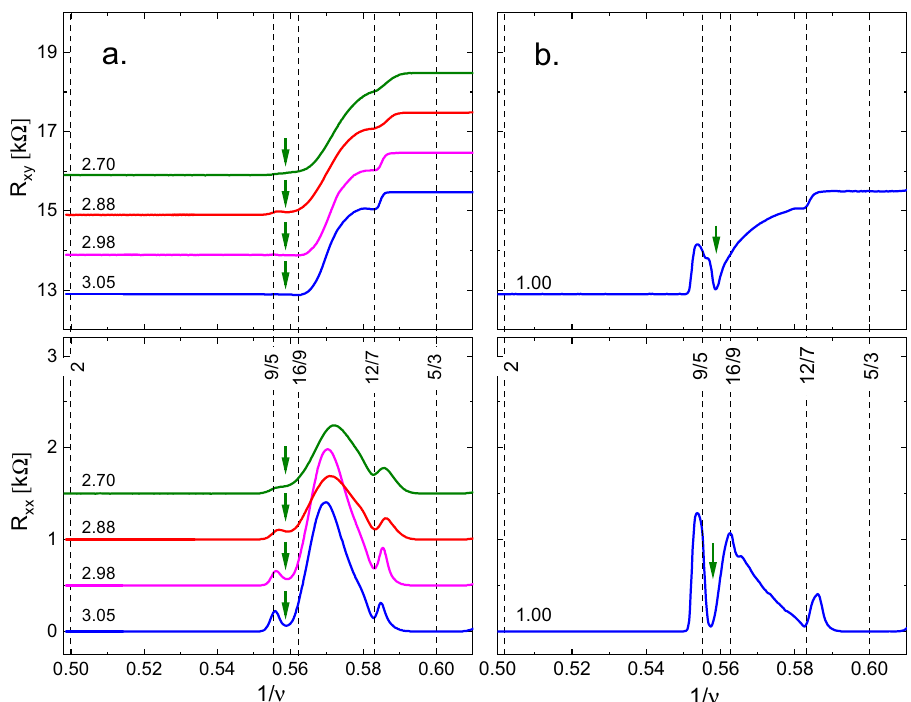
Fig. 3 Reentrant integer quantum Hall Wigner solids in a variable density sample and a sample of fi xed density. a Waterfall plots of the magnetoresistance R xx and Hall resistance R xy as plotted against the inverse fi lling factor 1/ ν of Sample 1 as prepared at different electron densities. Measurements were performed at the temperature of T = 12 mK. b Magnetoresistance R xx and Hall resistance R xy as plotted against the inverse fi lling factor 1/ ν of Sample 2 of a fi xed electron density. This density is signi fi cantly lower than that of Sample 1. Measurements were performed at the temperature of T = 5.1 mK. Labels on traces indicate electron densities n in units of 10 11 cm − 2 . Vertical dashed lines mark locations and values of fi lling factors ν of interest and arrows mark the reentrant integer quantum Hall Wigner solid (RIQHWS). With the exception of traces at the highest density, traces for Sample 1 are shifted vertically upward for